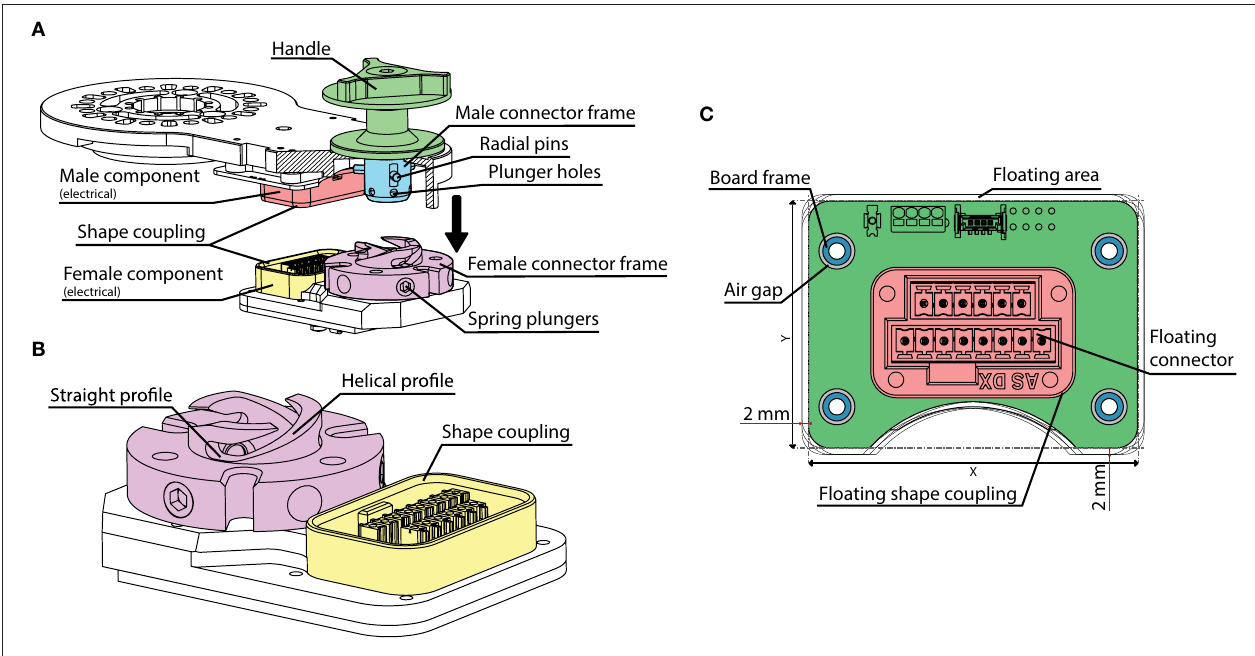
FIGURE 5 | The quick release electromechanical connector. (A) General assembly and main components of the mechanism. (B) Detail of the female component. (C) The floating electrical connector board. The floating connector and its frame (Floating shape coupling) are fixed to the board. An air gap is left between the board’s fixation holes to implement a floating area of 2mm in both the vertical and horizontal directions.